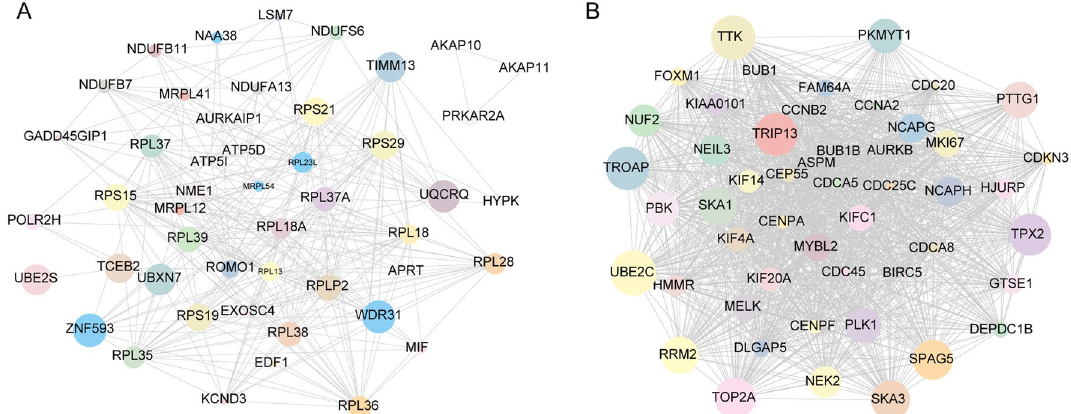
Figure 5. Weighted gene co-expression network analysis of gene interaction networks in key gene modules of PCa ( A ). The top 50 genes with the highest levels of intramodular connectivity in the blue module. ( B ). The top 50 genes with the highest levels of intramodular connectivity in the green module. (The size of the circle represents combined scores).